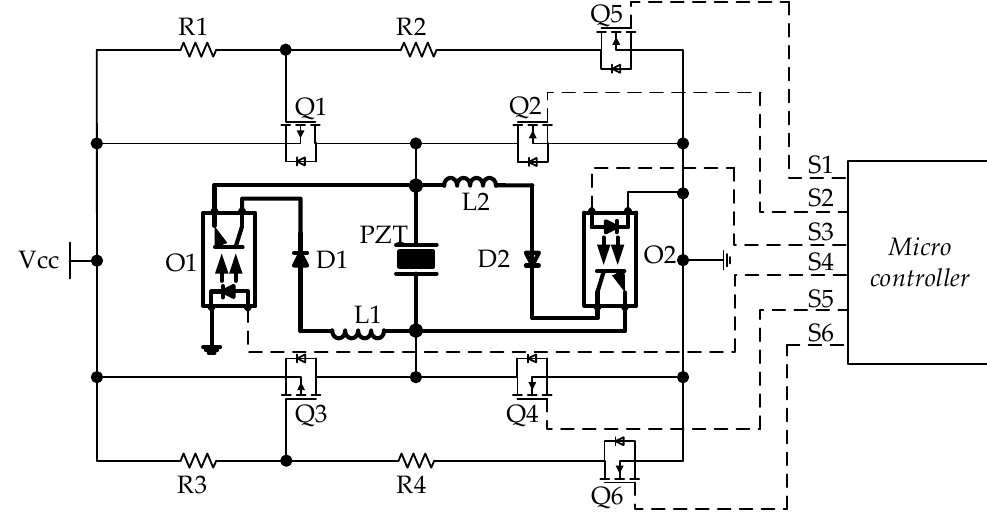
Figure 9. Double inductor-based driving (DID) circuit.